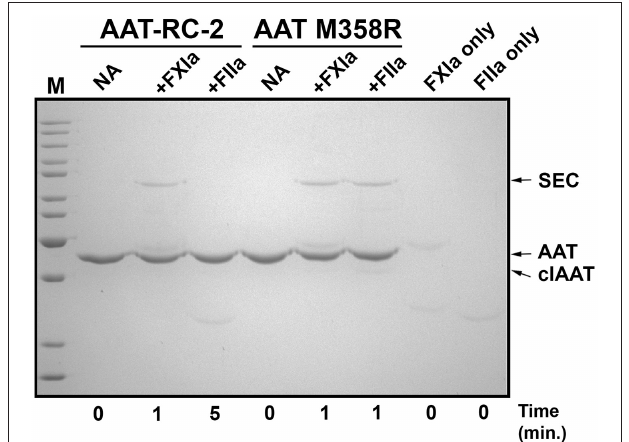
FIGURE 2 | AAT-RC-2 forms sodium dodecyl sulfate (SDS)-stable complexes with FXIa but not with thrombin. A 10% SDS-polyacrylamide gel electrophoresed under denaturing and reducing conditions and stained with Coomassie Blue is shown. Reactions contained purified AAT-RC-2 or AAT M358R (identified above horizontal bars indicating the relevant lanes) in the absence (no addition, NA) or presence of FXIa ( + FXIa) or thrombin ( + FIIa). AAT variants (1.0 µ M) were reacted with protease (0.1 µ M) for the time, in minutes, indicated below the lanes, at 37 ◦ C. Arrows, at the right, highlight the position of intact AAT (AAT), cleaved AAT (clAAT), and serpin–enzyme complexes (SEC) of AAT-FXIa or AAT-thrombin. M denotes molecular weight markers, in kDa: 200, 150, 120, 100, 85, 70, 60, 50, 40, 30, and 25. The scanned image of the gel was uniformly darkened in Adobe Photoshop by setting the brightness to − 50 (full scale 0 to − 150) to maximize band visibility.